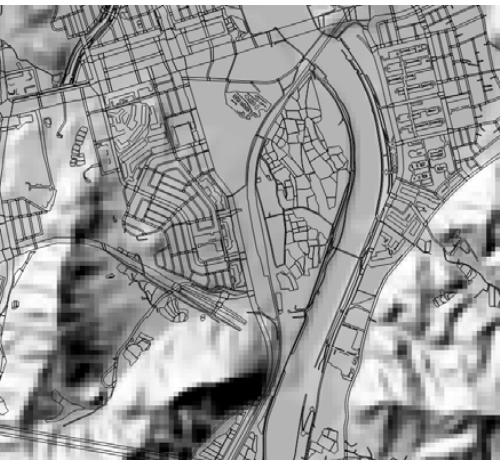
Figure 3. An example of a selected map layer and generated DEM.